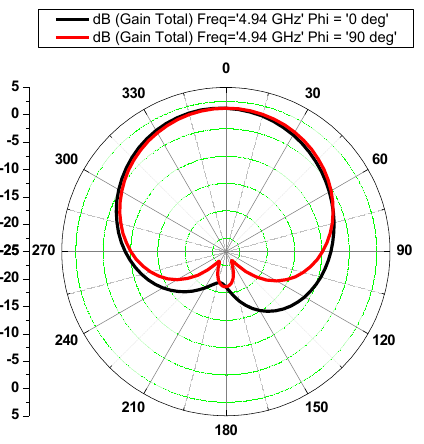
Table 3:. Results of Optimized Basic Triangular Patch Antenna S.No